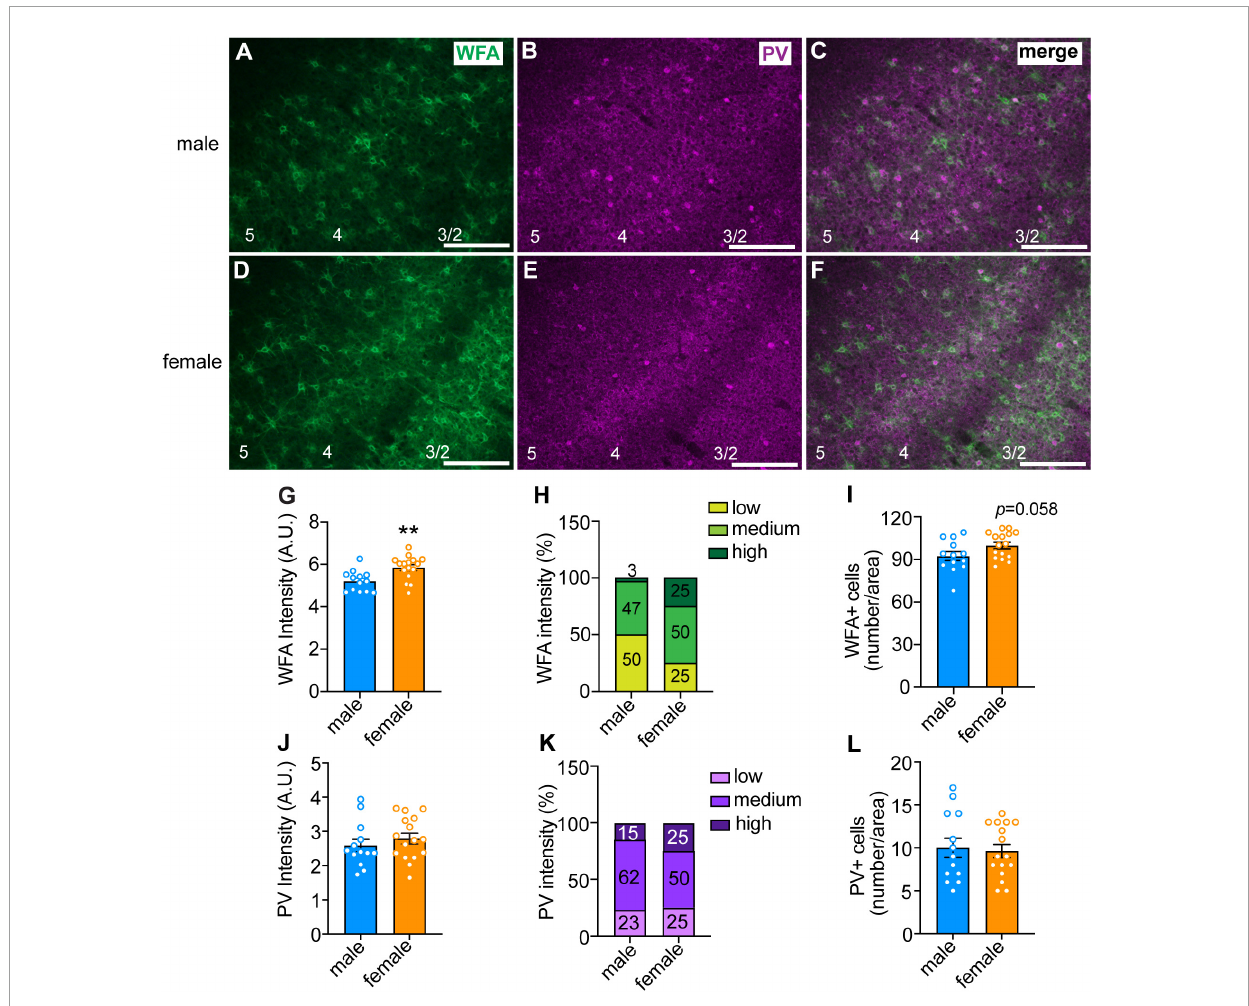
FIGURE2 Sex differences in perineuronal net (PNN) intensity in the anterior insula. (A–F) Representative images of male (top panels) and female (bottom panels) insula sections that were fluorescently labeled with Wisteria floribunda agglutinin (WFA, in green), which binds to PNNs, and parvalbumin (PV, in magenta). Scale bar, 200 µ m. Cortical layers are indicated at the bottom of the images. Quantified WFA (G) and PV (J) fluorescence intensity. Each data point represents the average intensity surrounding neurons in a single section, with ∼ 100 cells per section analyzed in 2–4 sections per mouse from 4 mice per sex. ** P < 0.01. Percentage of neurons with low, medium, and high intensity PNNs (H) and PV staining (K) . There was a significant sex difference in PNN intensity, with females having more high intensity and less low intensity PNNs than males, X 2 = 9.77 × 10 - 37 . Average number of PNNs (I) and PV (L) neurons per section in males and